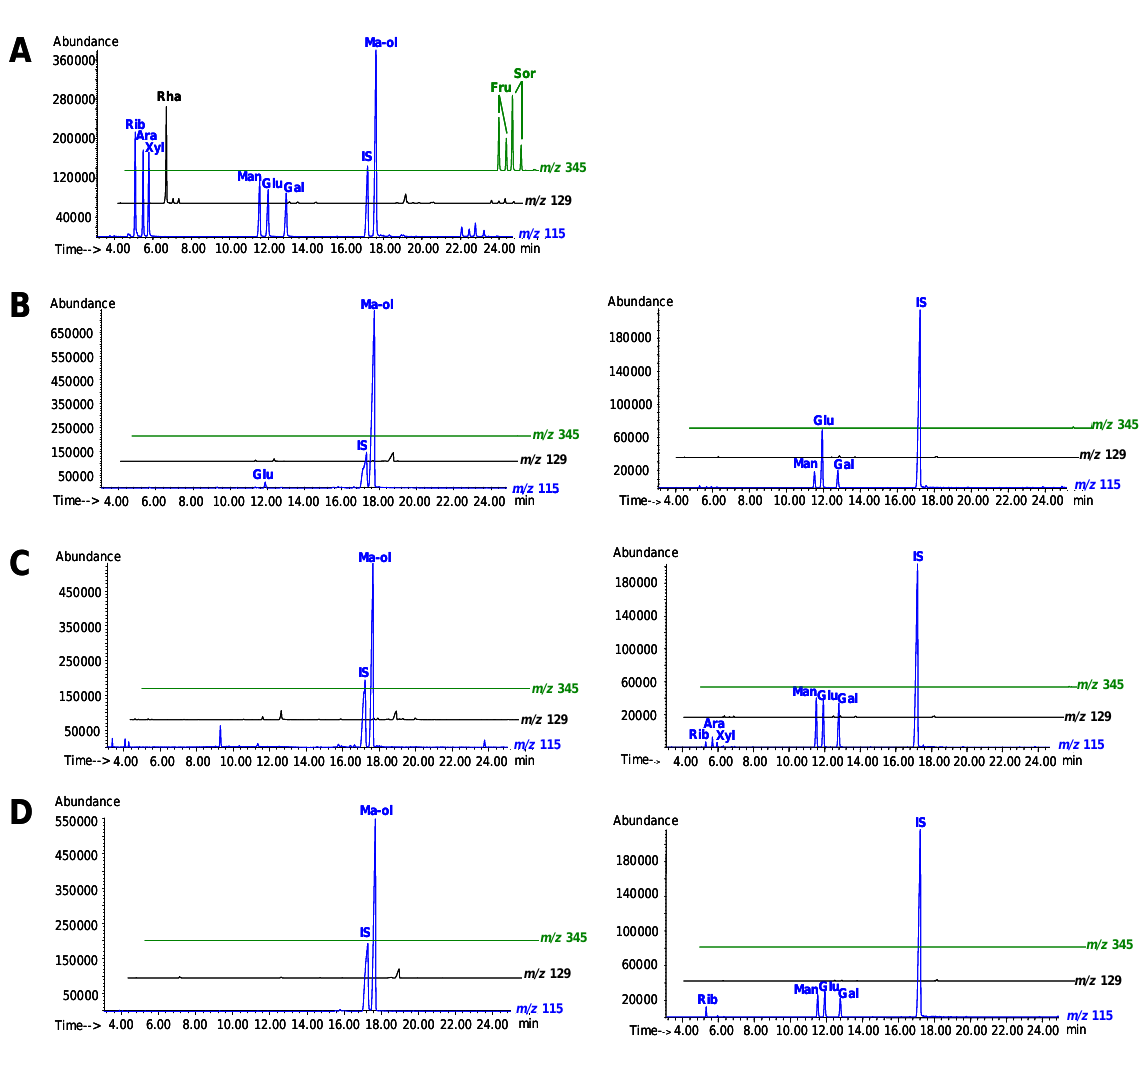
Figure 4. Typical SIM chromatograms of mixed standards (A), free (left) and conjunct carbohydrates (right) in natural Cordyceps sinensis (B), cultured C. sinensis (C), cultured C. militaris (D). Rha, rhamnose; Rib, ribose; Ara, arabinose; Xyl, xylose; Man, mannose; Glu, glucose; Gal, galactose; Ma-ol, mannitol; Fru, fructose; Sor, sorbose; IS, internal